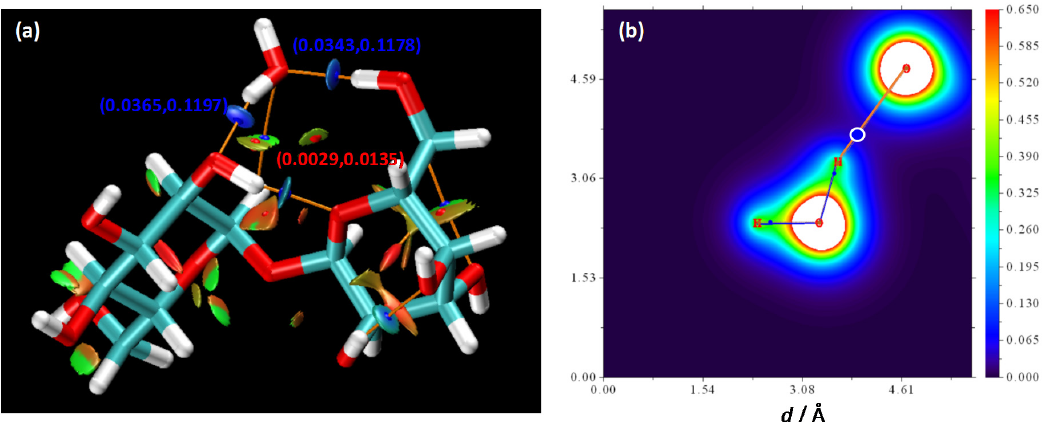
Figure 3. ( a ) AIM and RDG analysis of 1:1 THAL:water cluster. AIM binary (3, − 1) and ring (3, +1) critical points are showed as blue and red spheres, respectively. AIM bond paths are showed as orange lines. For relevant critical points (electron density and Laplacian of electron density), a.u. are reported. Colour code for RDF isosurfaces: (blue) hydrogen bonding, (green) van der Waals interactions and (red) repulsive interactions. ( b ) Contour map of electron density for the region of water–THAL interaction (water acting as hydrogen bond